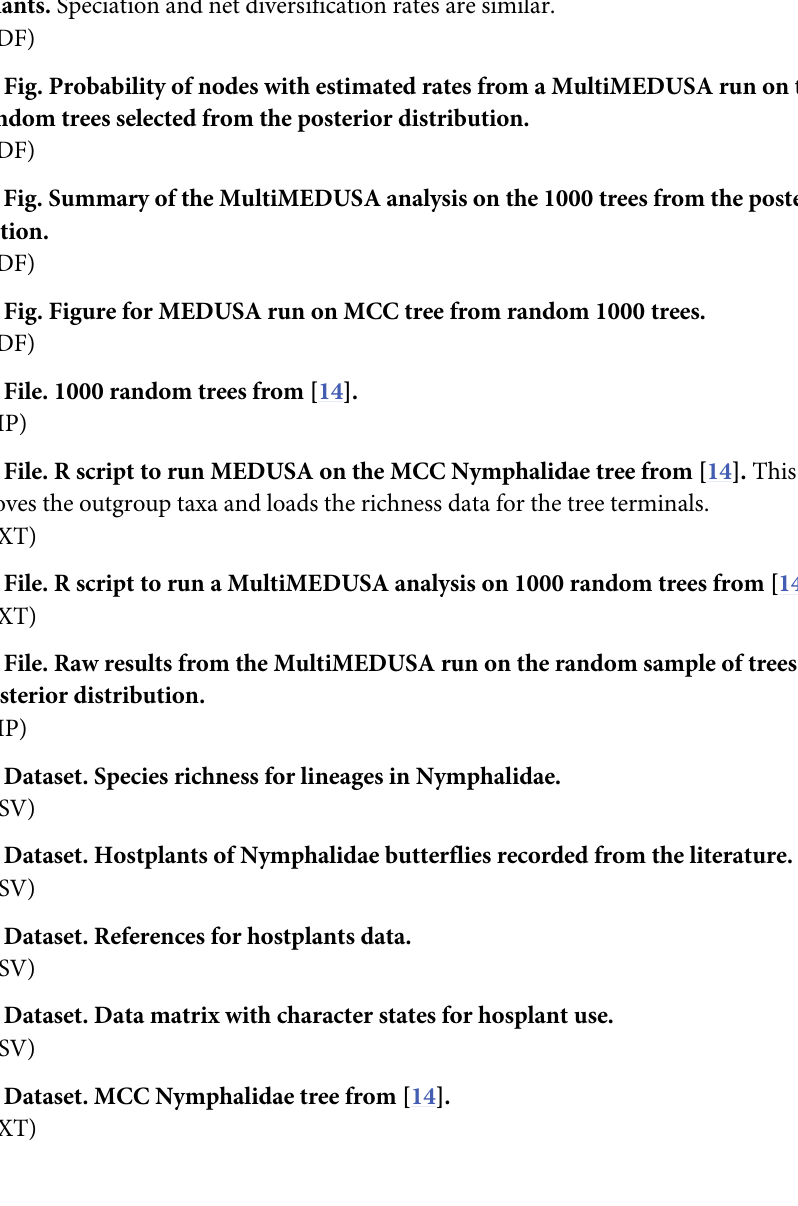
S6 Fig. Probability of nodes with estimated rates from a MultiMEDUSA run on the 1000 random trees selected from the posterior distribution. S7 Fig. Summary of the MultiMEDUSA analysis on the 1000 trees from the posterior distri- bution. S8 Fig. Figure for MEDUSA run on MCC tree from random 1000